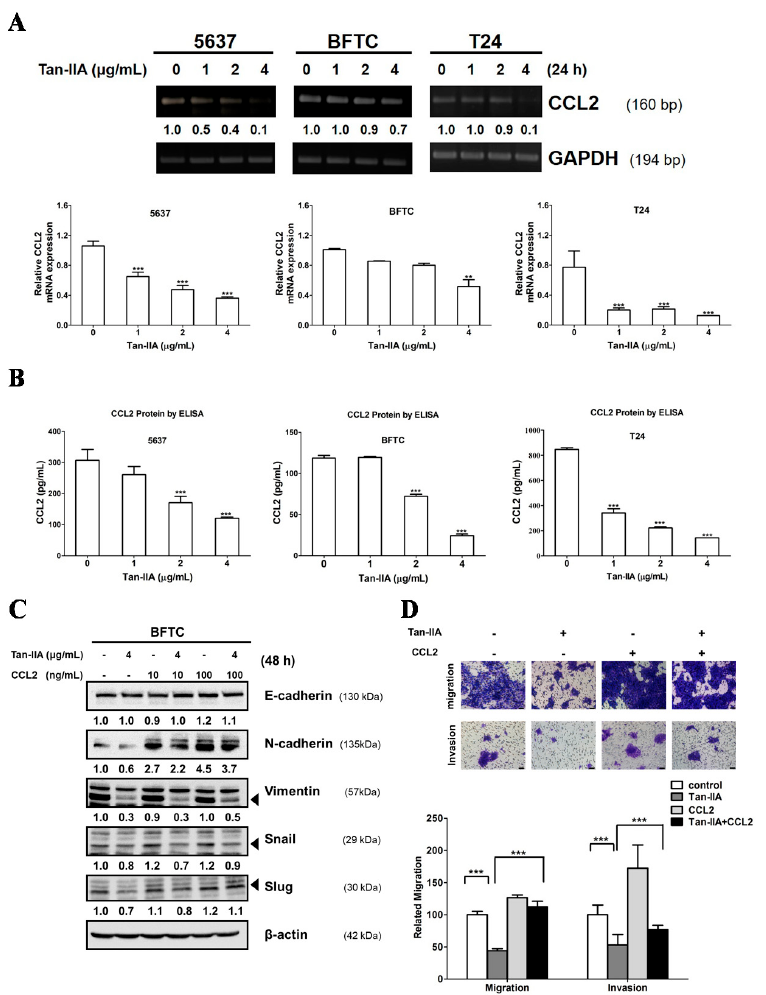
Figure 3. Tan-IIA inhibited the CCL2 expression and reversed the EMT in human BCa cells. ( A ) Human BCa cells were treated with increasing concentrations of Tan-IIA for 24 h. The expression of CCL2 was detected by PCR and qRT-PCR; ( B ) Human BCa cells were treated with increasing concentrations of Tan-IIA for 48 h. The supernatant was collected for CCL2 protein detection using ELISA assay; ( C ) BFTC cells were treated with or without 4 μ g/mL Tan-IIA in the presence or absence of CCL2 recombinant protein for 48 h. The EMT-related gene expression was detected by western blot; ( D ) BFTC cells were treated with or without 4 μ g/mL Tan-IIA in the presence or absence of 100 ng/mL human CCL2 recombinant protein for 24 h, followed by migration (24 h) or invasion (48 h) assays and analyzed as previous described. Data are presented as means ± S.D. from three different experiments. *** p < 0.001 versus vehicle.